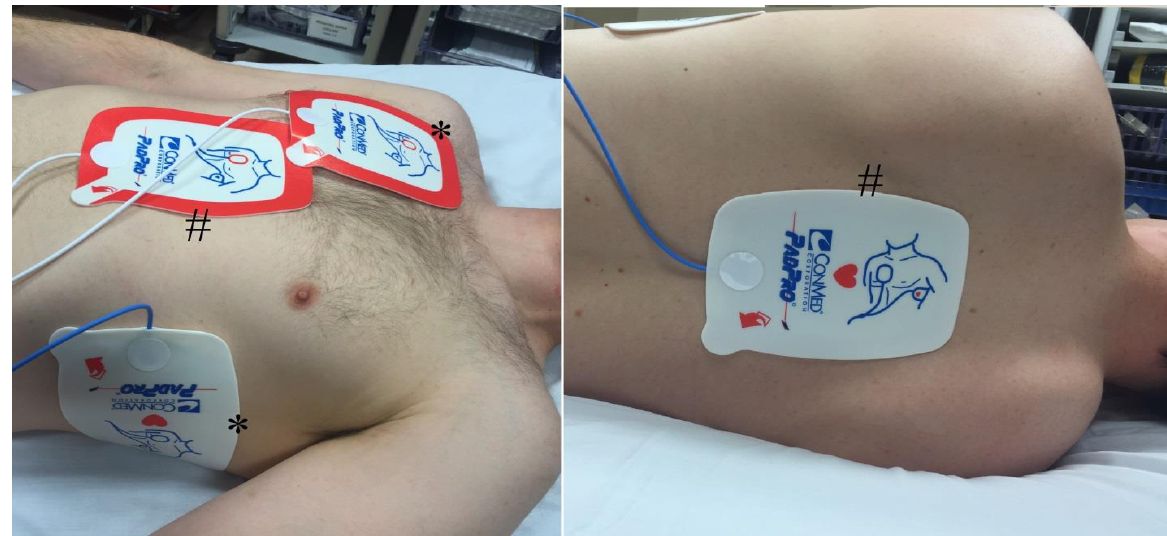
Figure 1. Reproduction of pad placement for dual-axis shock. Pads marked with the asterix (*) show the standard placement of pads, whereas the pads marked with the octothorp (#) signify the anterior-posterior placement for the second set of